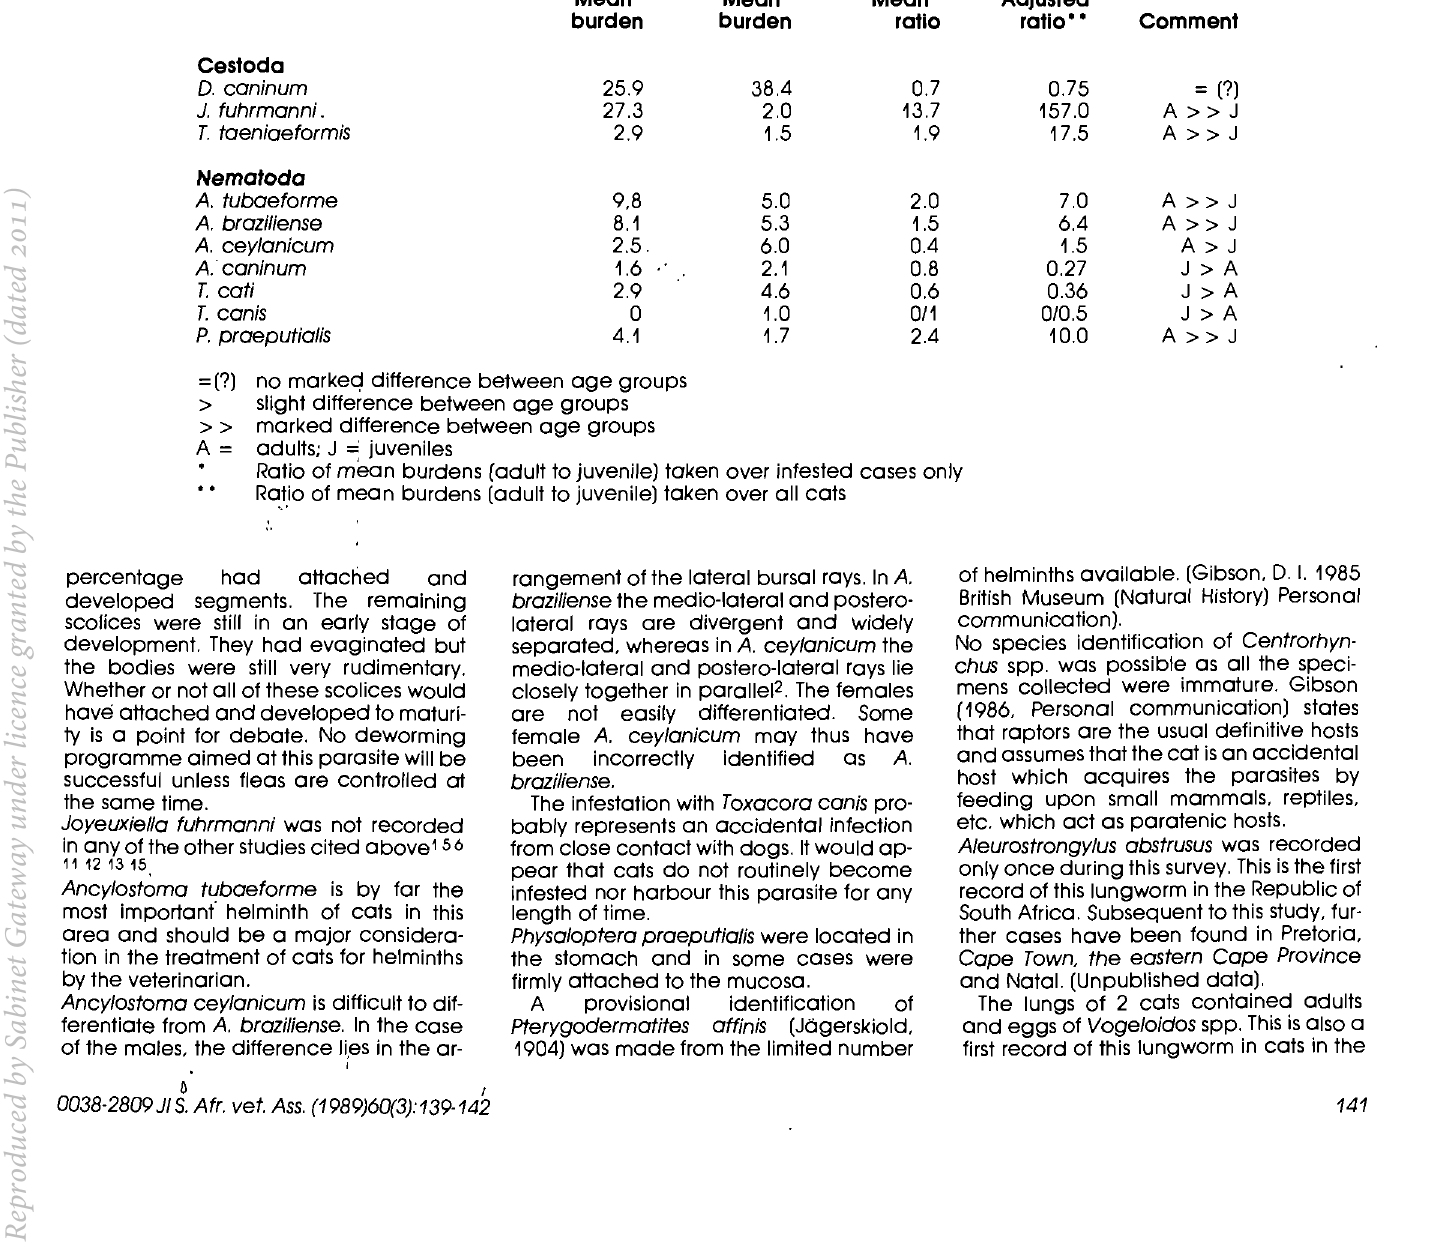
Adult Juveniles Adultsl Adultsl Juveniles burden ratio ratio' , Comment